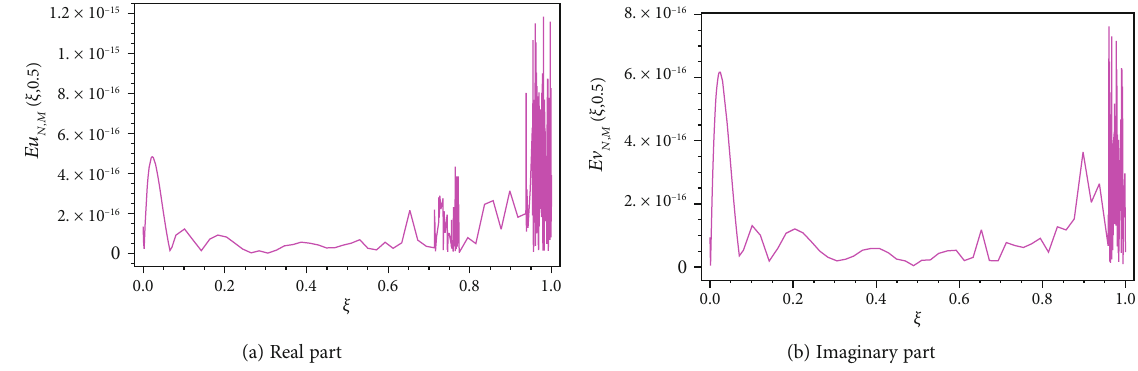
Figure 7: ξ -direction curves of real and imaginary parts of the absolute error of Equation